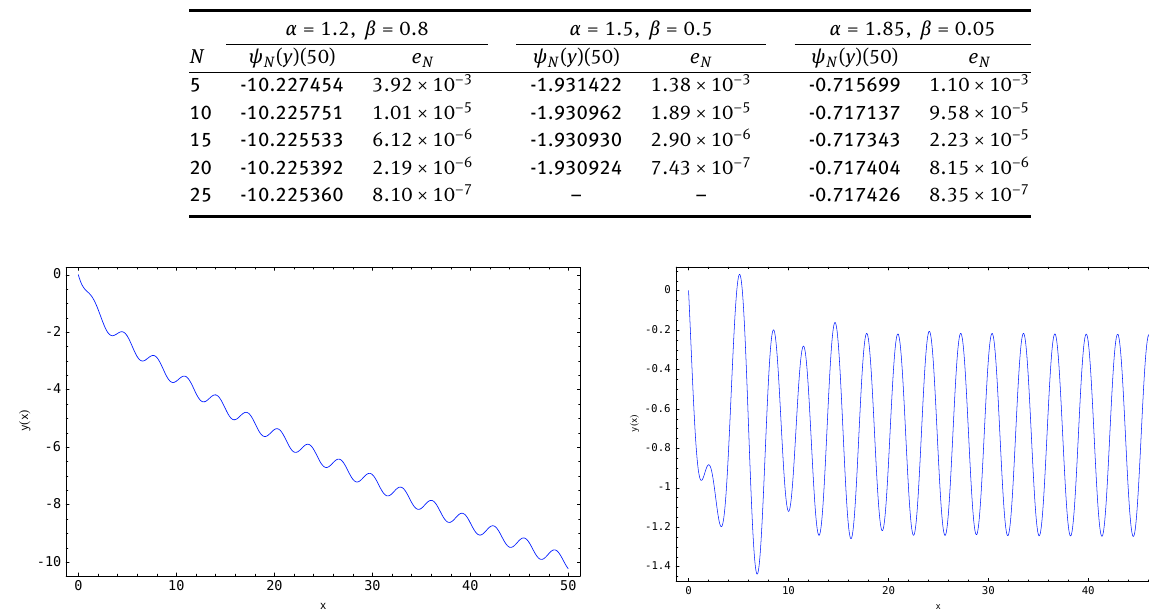
Fig. 12: Computational results of y ( x ) with h = 1 , N = 20 for α = 1.85, β = 0.05 for Example